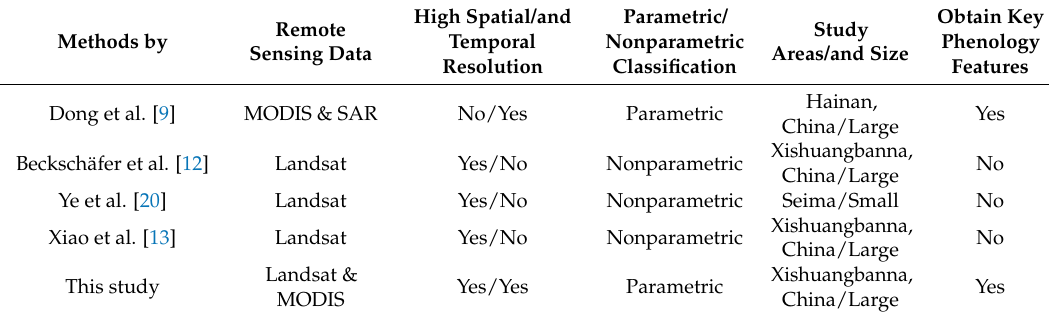
Table 4. Summary of main rubber plantation extraction